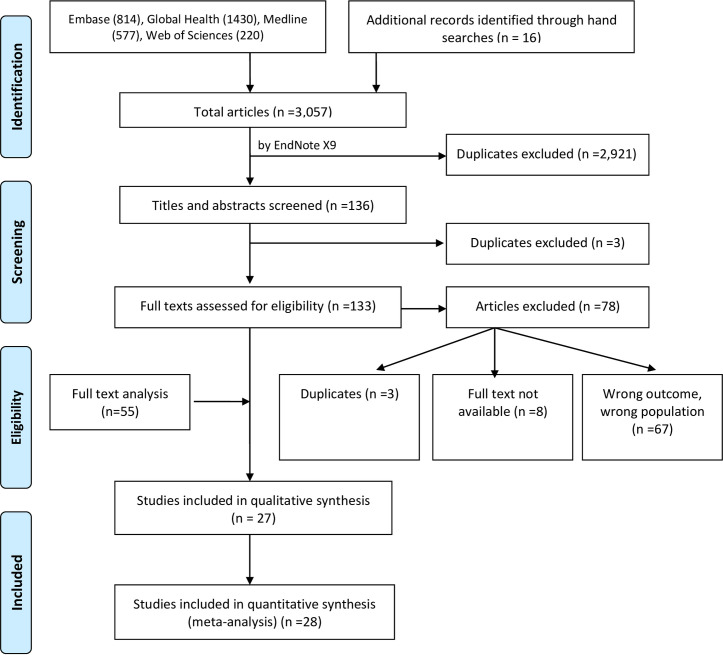
PRISMA flow diagram showing the process undertaken for inclusion and exclusion of studies in the systemic review.